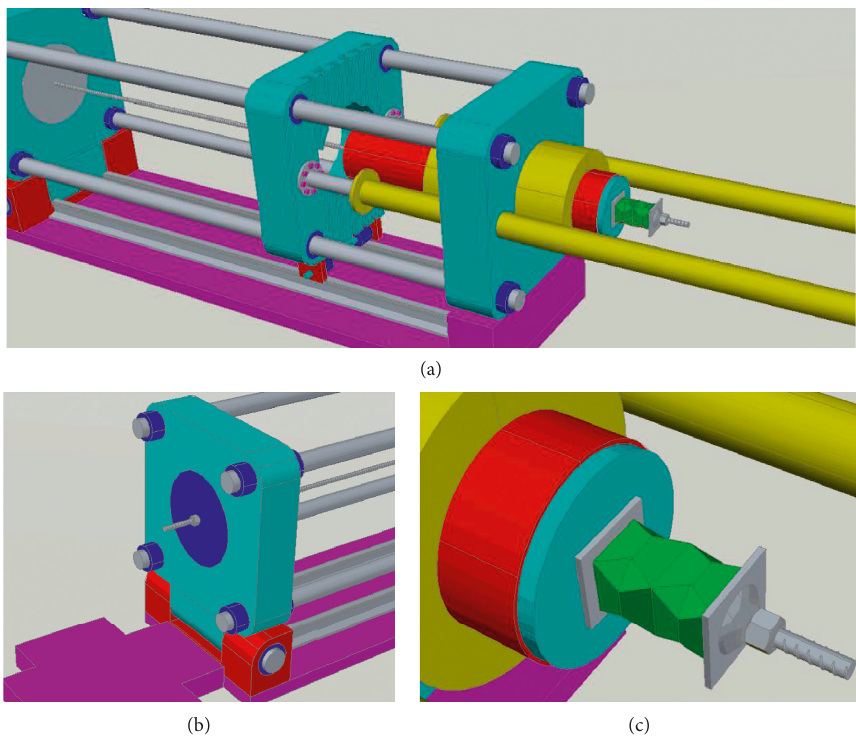
Figure 3: Schematic diagram of mine bolt/anchor